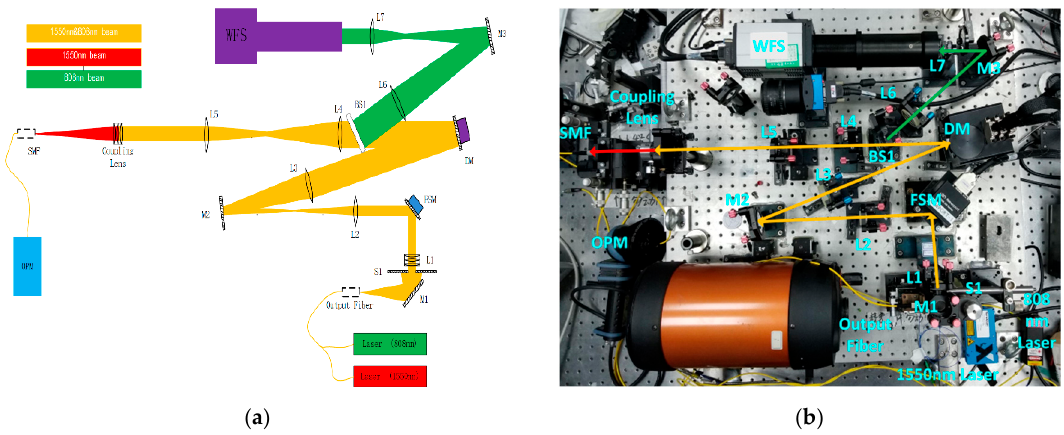
Figure 9. ( a ) Schematic diagram of experimental system; ( b ) photograph of experimental system. M: Mirror; L: Lens; S: Aperture stop; FSM: Fast-steering mirror; BS: Beam splitters; DM: Deformable mirror; OPM: Optical power meter; SMF: Single-mode fiber.